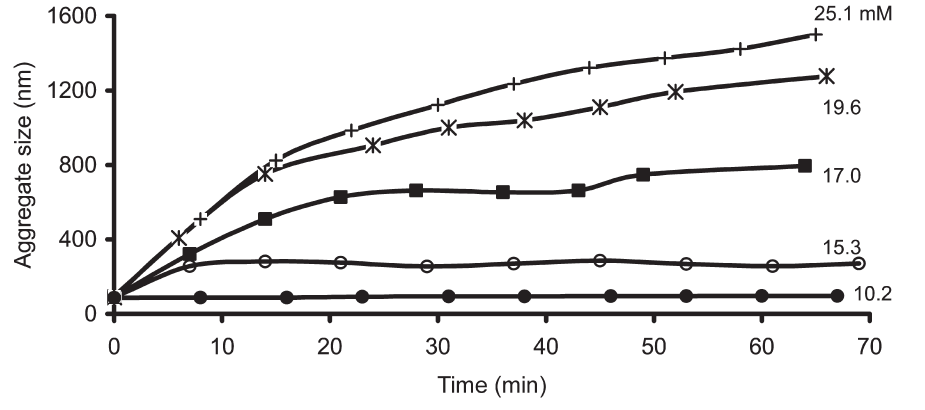
Figure 3. Effect of Ca 2+ con- centration (10.2–25.1 mM) on the time course of mean PLFE particle diameter in 50 mM KCl at 40 °C.